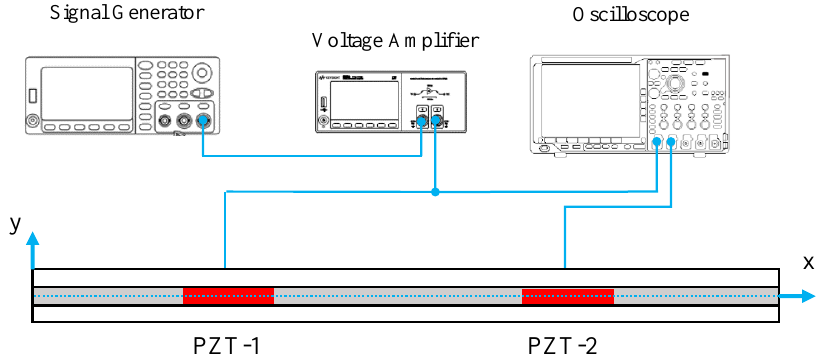
Figure 5. Schematic of the experimental setup for testing laminate specimen consists of two d35 PZT embedded within the bondline in a pitch-catch configuration.